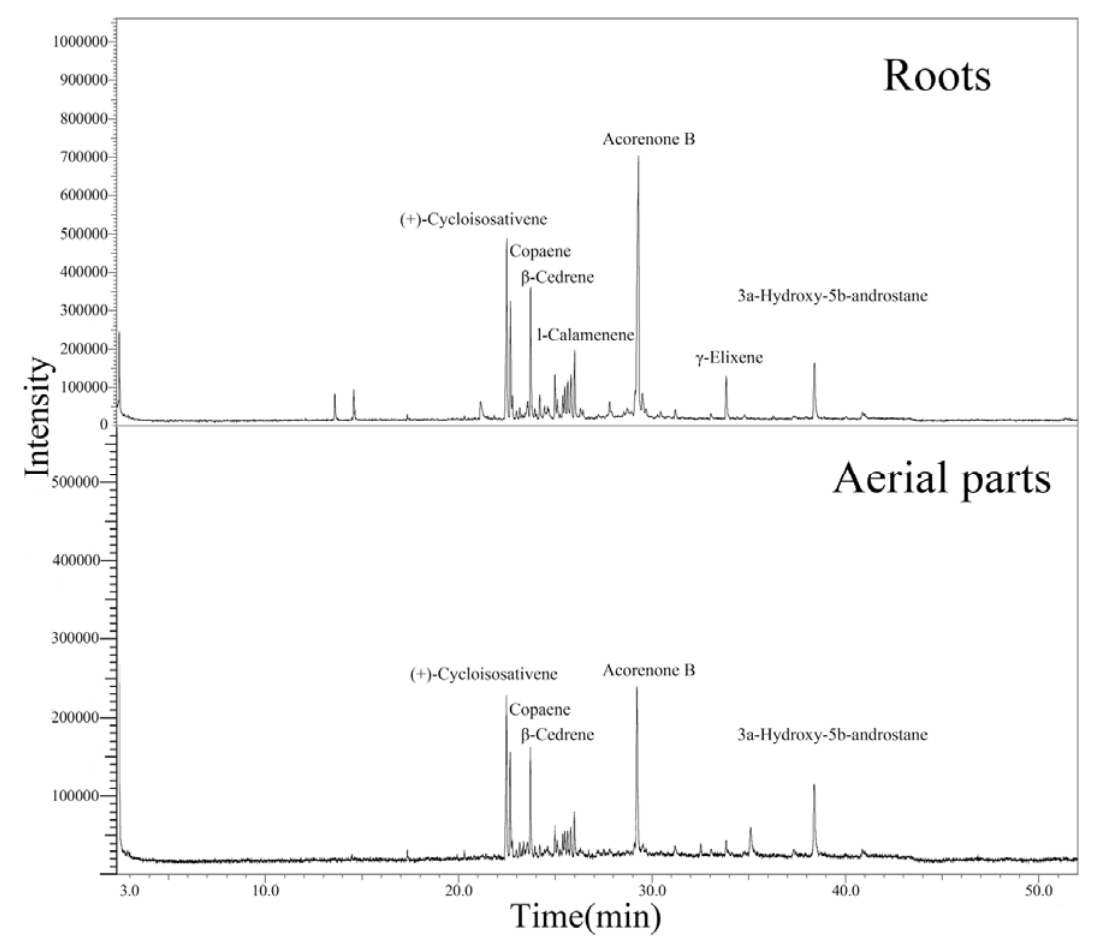
Figure 1. Typical GC/MS chromatograms of the chemical profiles for the E. macrorrhiza essential